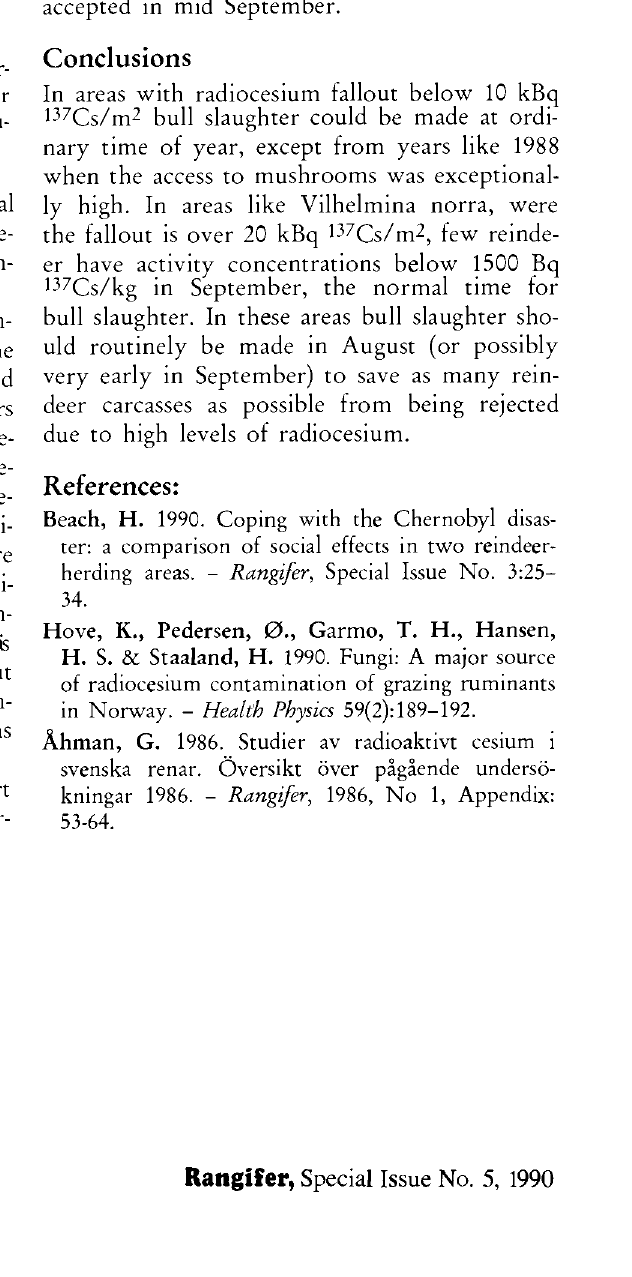
Figure 1. The number of accepted and rejected car casses Bq/kg) at reindeer slaughters in Vilhelmina norra in July/Au¬ gust and September